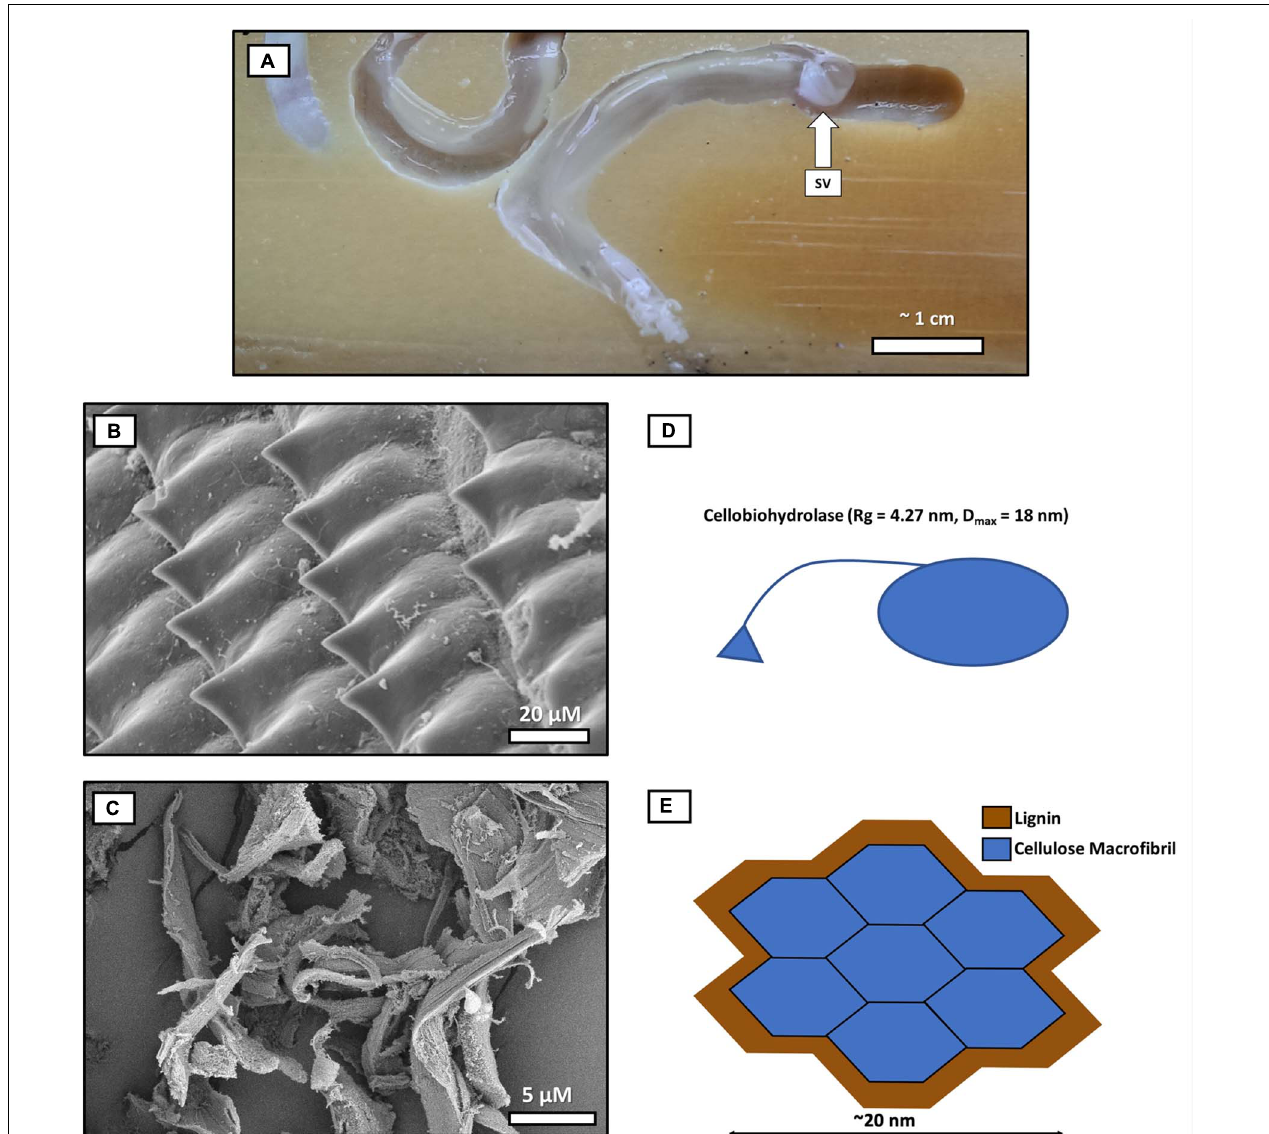
FIGURE 1 | The comparative scale of a cellulose “macrofibril” and cellobiohydrolase enzyme relative to average-sized wood particles produced by shipworm shell valves. This diagram uses the 36-chain elementary fibril model for comparative purposes (Song et al., 2020) as physically, it is the largest generally accepted current model for cellulose configuration at the molecular level. (A) Shipworms burrowing into wood. One shipworm (right) is partially retracted in its burrow, and the boring shell valves (SV) are designated with an arrow at the anterior end of the animal. (B) Shipworm shell valve denticles rasp away the wood as the shipworm bores, producing (C) comminuted wood particles (measuring approximately 20 µ m) which enter the gut. (D) Cellulose macrofibril (blue) encrusted with lignin (brown). Both the macrofibril and the cellobiohydrolase, (E) are ∼ 1,000 times smaller than the average wood particle produced by the rasping action of shipworm’s valves. Cellobiohydrolase and other CAZymes are unable to initiate digestion of even the relatively large cellulose macrofibril models until the encrusting lignin is removed by chemical or enzymatic action (Cellulose elementary fibril models with 18 or 24 chains would be smaller yet in comparison to even the smallest wood particles produced by shipworms in the shell grinding/comminution process). Comminution of wood by the shipworm valves does not alter the chemistry of lignin, and literature does not support that comminution would create required accessibility to cellulose at the nano-scale. SEM prep for images B,C : Shipworms and digestive tissue/frass was fixed in glutaraldehyde and post-fixed in osmium tetroxide before critical point drying. Imaging was conducted using a Hitachi S-4800 field emission scanning electron